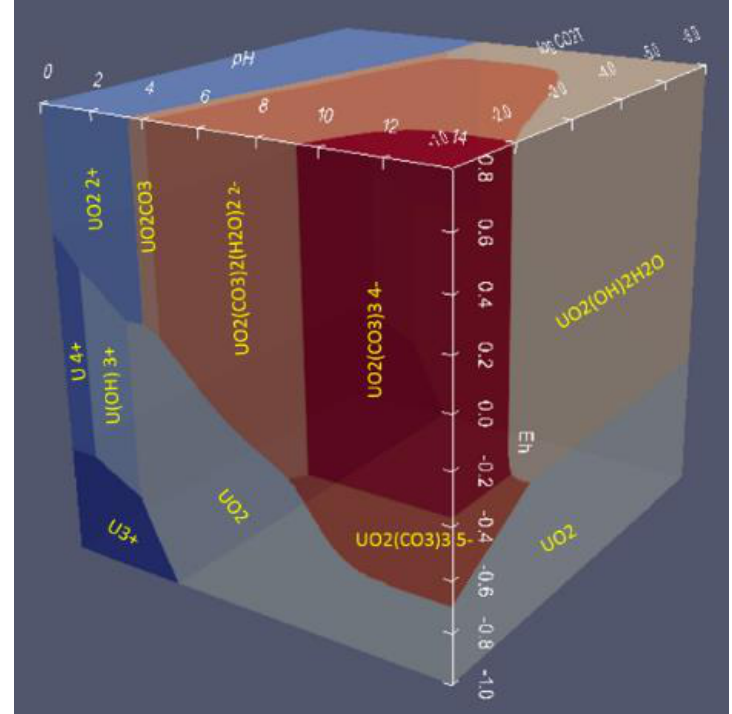
Figure 28. The transparent view of the 3D plot. Each colored area is labeled with the name of the species.